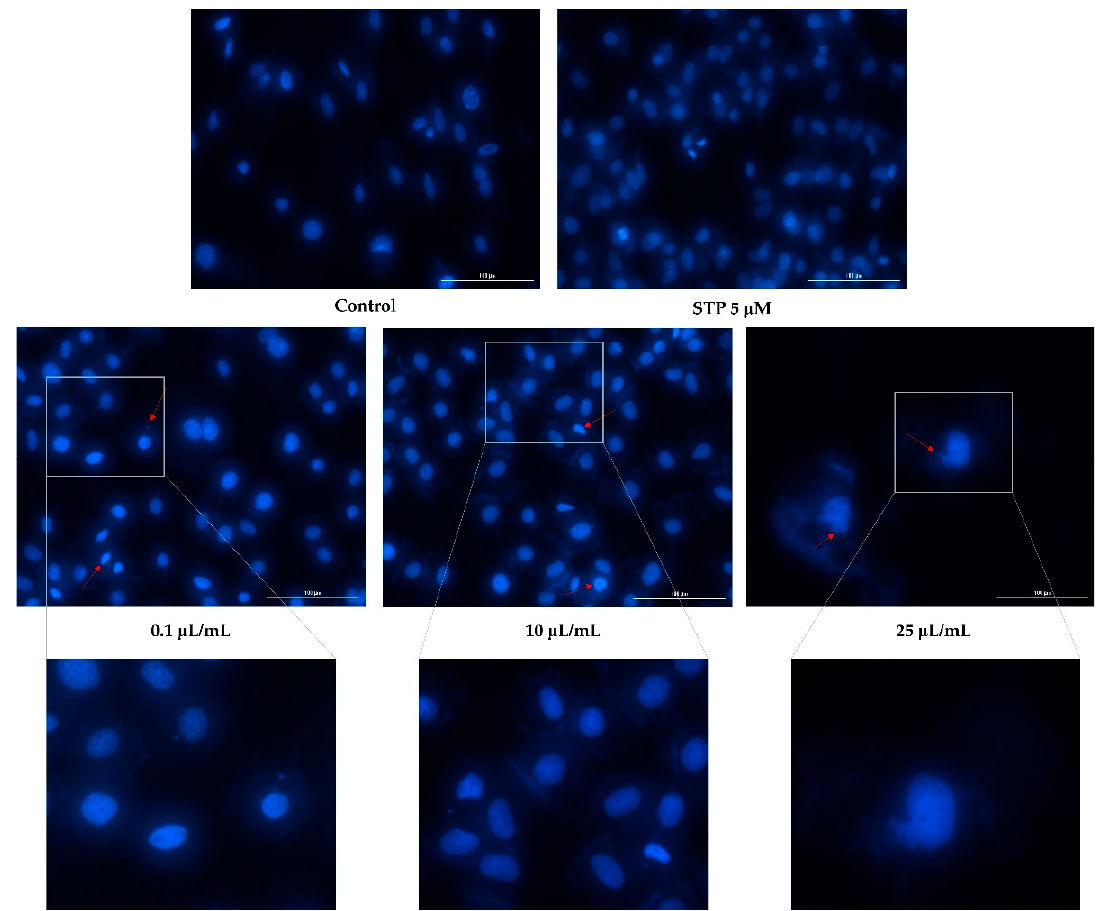
Figure 7. Cardiomyocytes—H9C2(2-1) nuclei stained with Hoechst 33342 dye after 24 h treatment with nicotine (0.1, 10, and 25 μ L/mL). Staurosporine (5 μ M) was used as the positive control for apoptotic changes at the nuclear level. The red arrows indicate signs of apoptosis. The scale bars represent 100 μ m.